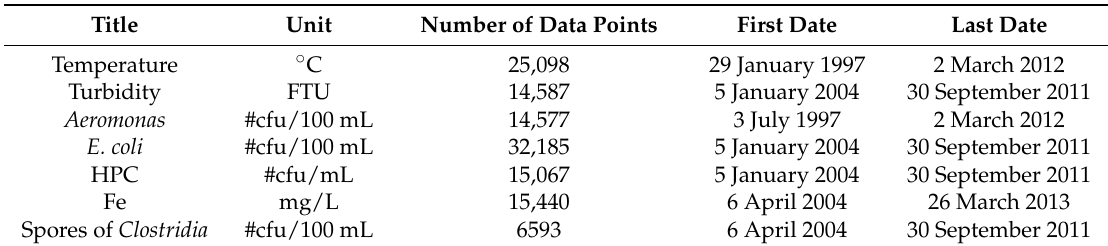
Table 2. Dutch water quality